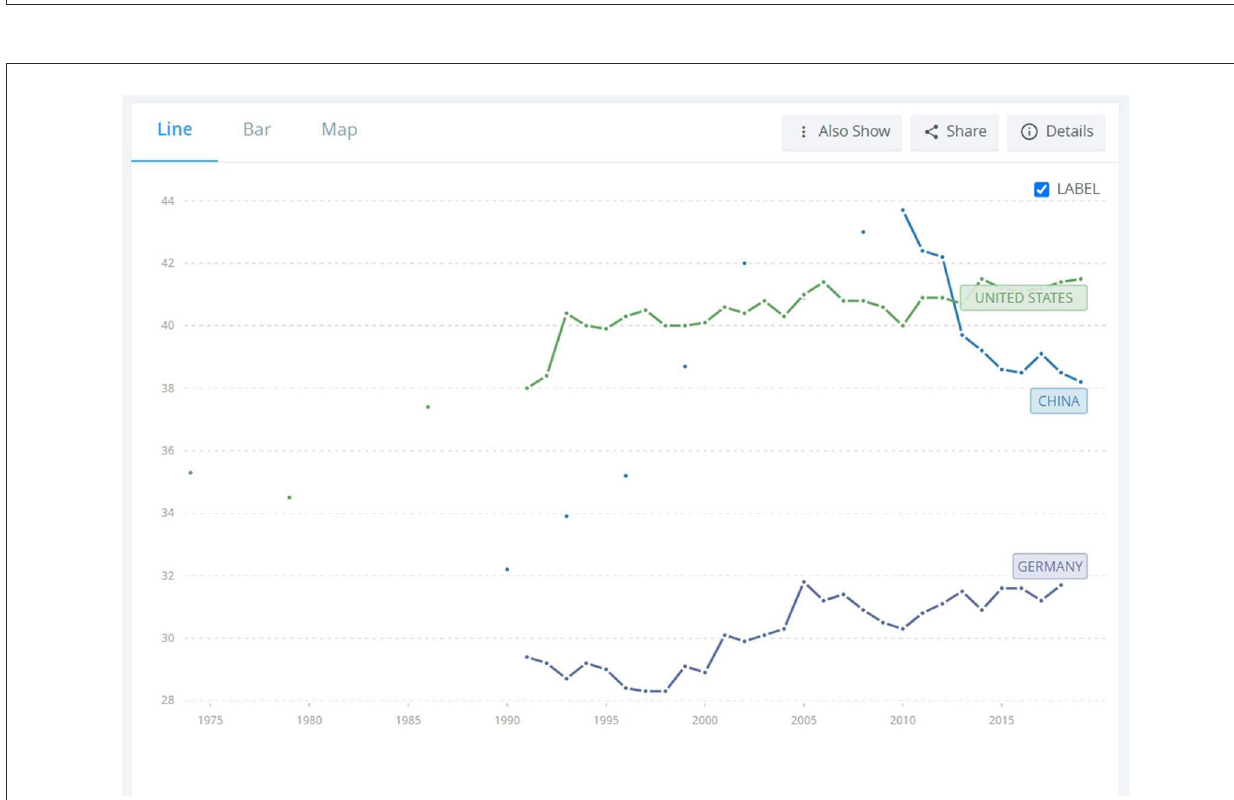
FIGURE12 GINI index, comparison between US, China and Germany. Available online at: https://data.worldbank.org/indicator/SI.POV.GINI?locations=CN-US- DE (accessed February 06,